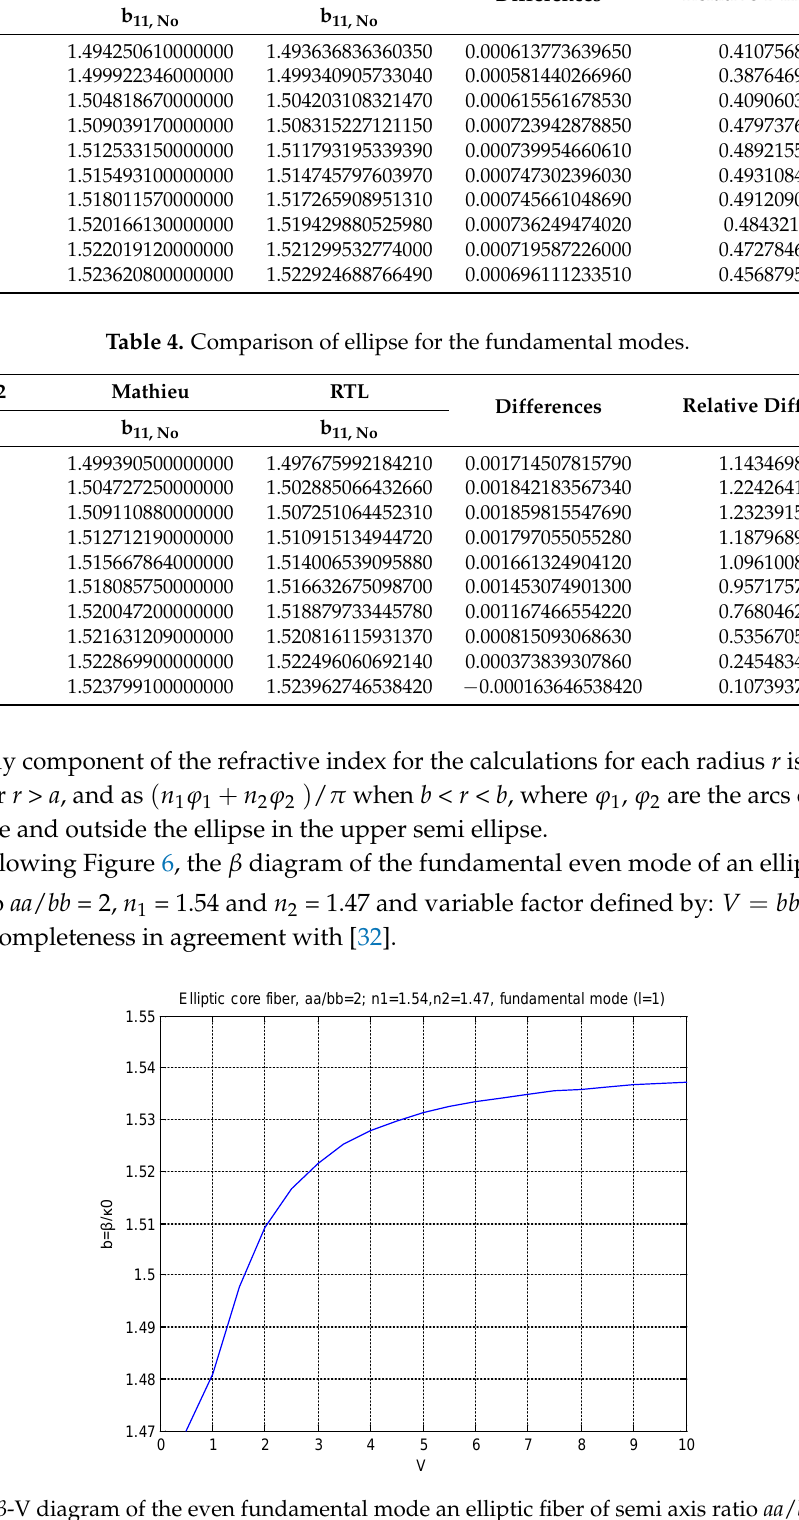
Figure 7. Rectangular core fiber of semi-sides aa and bb , for r < bb , n = n 1 , for r > aa , n = n 2 , for bb < r < aa , n 2 < n < n 1 .